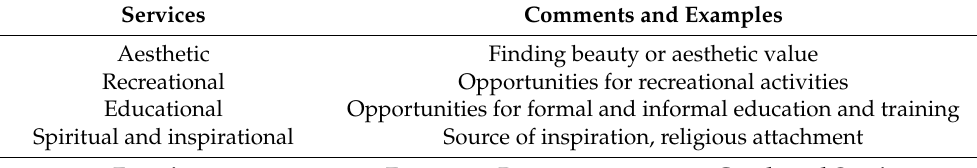
Table 1. Cultural ecosystem service classification and